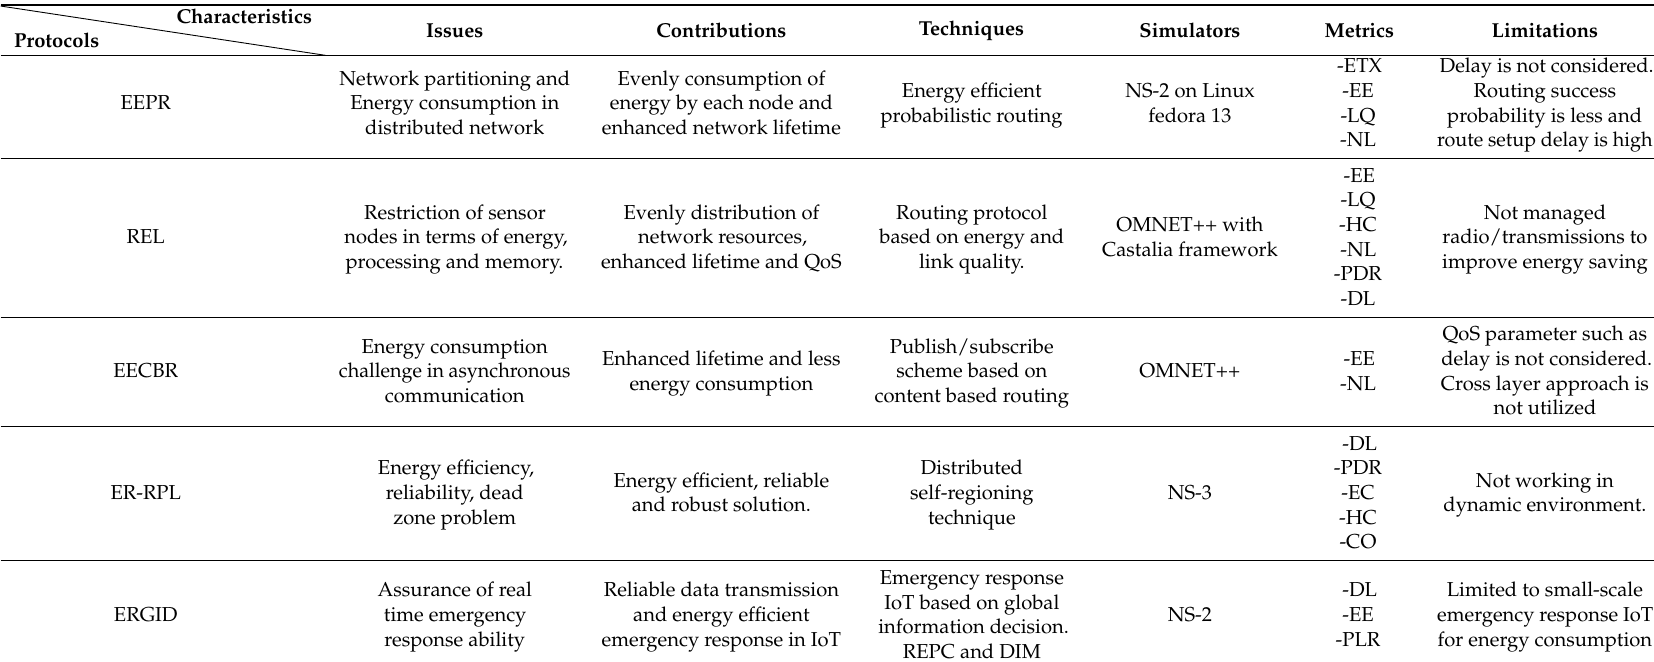
Table 10. Summary of energy efficient routing techniques.